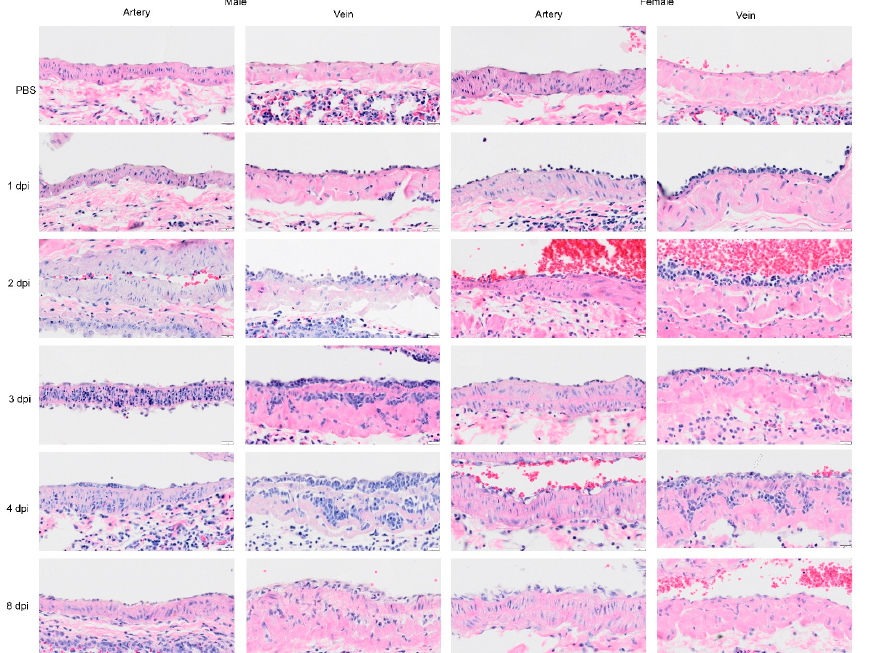
Figure 9. Selected H&E images of the large pulmonary blood vessels from Syrian hamster following infection with SARS-CoV-2 on 1, 2, 3, 4, and 8 dpi. In the sham inoculated group (PBS), the main pulmonary artery and veins display a normal character in each layer of the blood vessel. In subsequent rows, representative images of pulmonary artery and veins are presented for 1, 2, 3, 4, and 8 dpi. The pulmonary artery at 1 dpi is normal, although in one female hamster, a few leucocytes were attached to the tunica intima. At 1 dpi, the image of the pulmonary vein shows leucocytes attached to the wall of pulmonary veins. At 2 dpi, blood vessels show an increased level of inflammatory cells or leucocytes penetrating through endothelial cells, and tunica intima, and appeared to be greater in the vein. The image on 3 dpi shows neutrophils that have penetrated through tunica media of pulmonary artery (male) or less severe (female). In the image of the pulmonary veins, the inflammatory cells have clotted in the tunica media. The image on 4 dpi shows inflammatory cells passing through an intact endothelial cell layer of the artery (male) although some vacuoles are present in endothelial cells and in muscle cells (female). The image of the vein shows the infiltration and proliferation of mononuclear cells. Mitosis was also noted in the endothelial cells (arrow in female vein implies proliferation of endothelial cells). We also noted groups of increased cells with single nuclei in the tunica media (smooth muscle cells). By 8 dpi, there was a decrease in the level of inflammatory cells infiltrating the blood vessels (recovered), and a higher density of endothelial cells in tunica intima. Scalebar = 20 µ